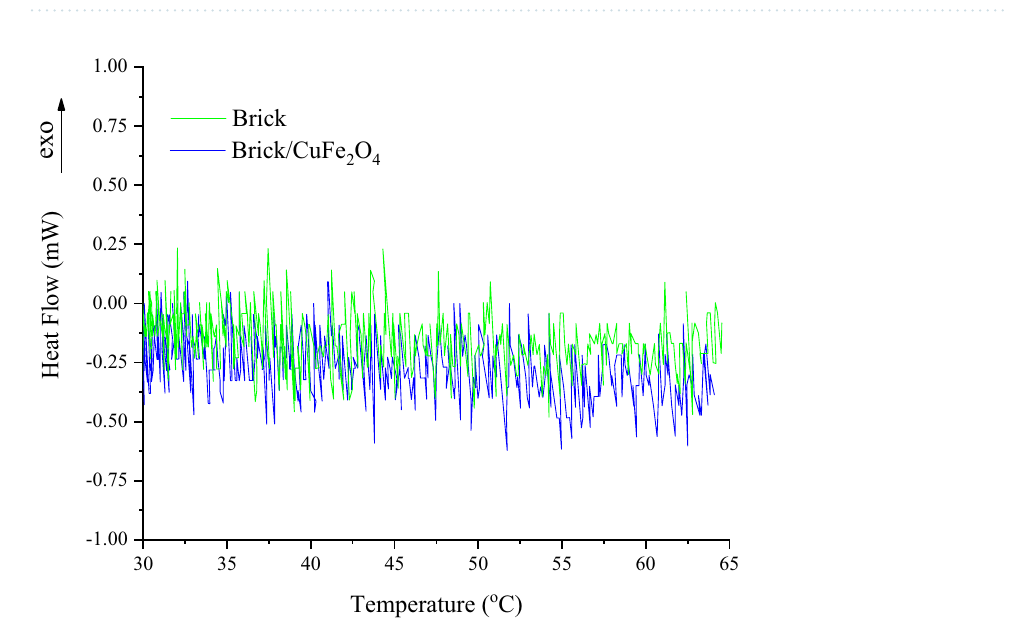
Figure 4. Optical characteristics comprising the light absorption at λ = 200–800 nm ( a ), energy band gaps ( b ), and IR energy absorption ( c ) of the samples as well as used setup to investigate IR absorption of samples ( d ).